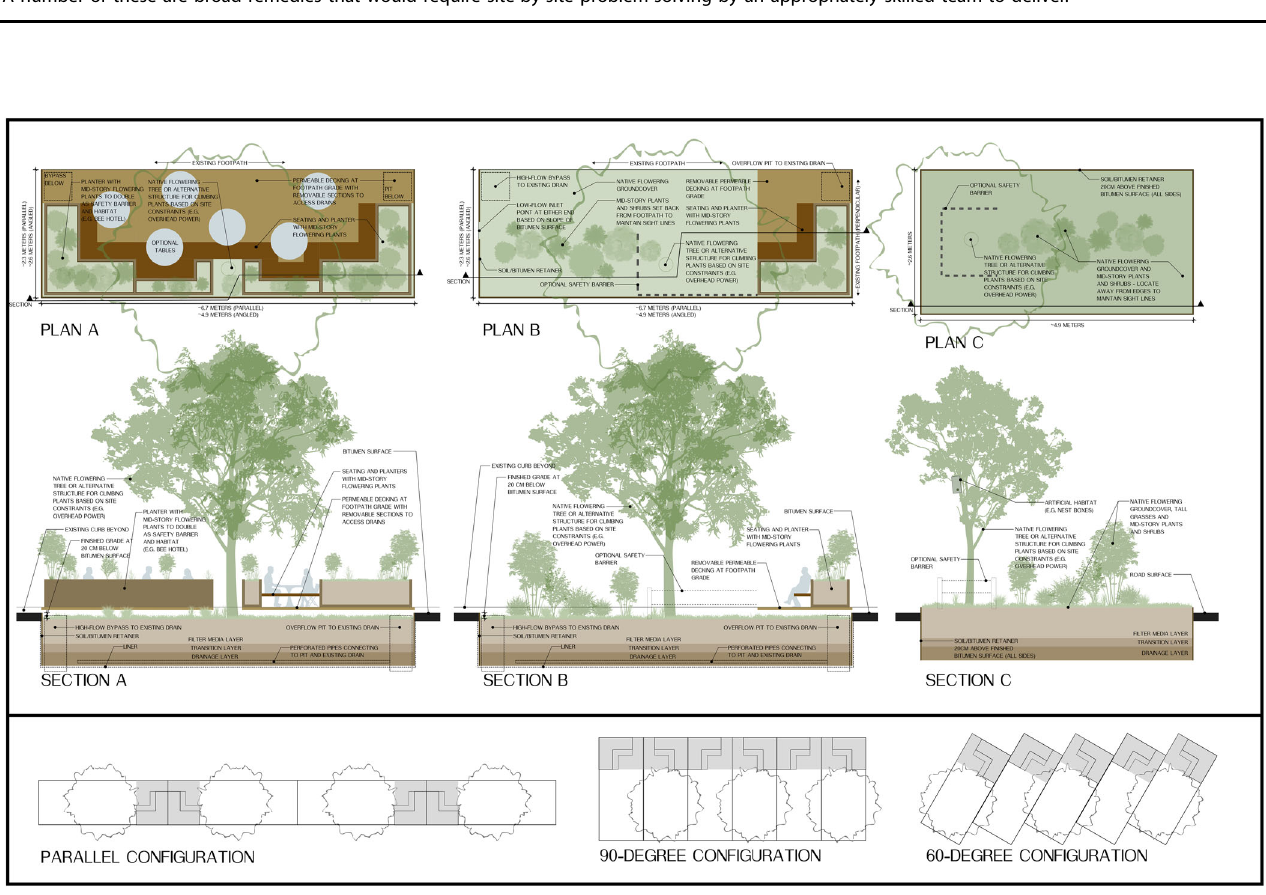
Fig. 5 Schematic designs modelled in this study. These are tailored to replace different kinds of redundant parking. The design on the left replaces kerbside parking in commercial areas, the centre design replaces kerbside parking in all other locations, and the design on the right applies to median parking. A range of kerbside alignments can be accommodated, as shown at the bottom of this fi gure. For clarity, we have omitted the planned subsurface reinforced receiver sleeves for site accessories such as barriers, furniture, and auxiliary